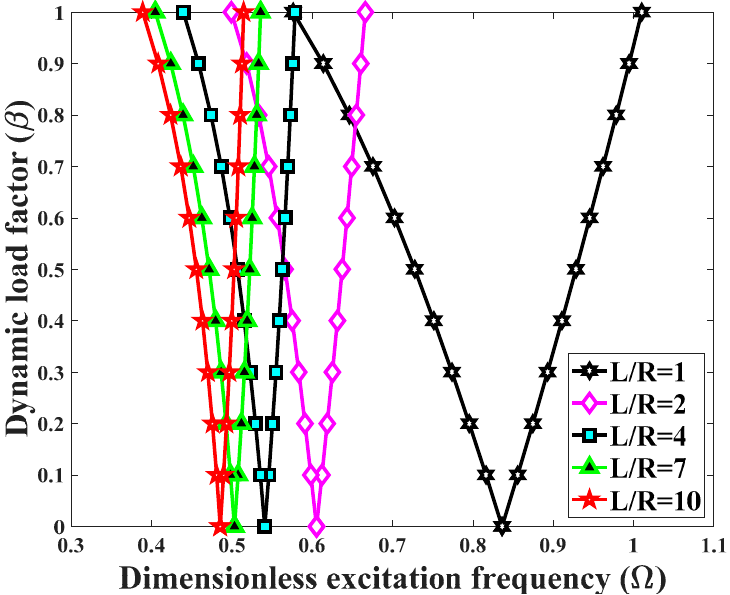
Figure 4. Effect of the length-to-radius ratio on the DIR for a BD-FG cylindrical shell with R = 0.5 m, h / R = 0.02, n x = n z = 1, α =